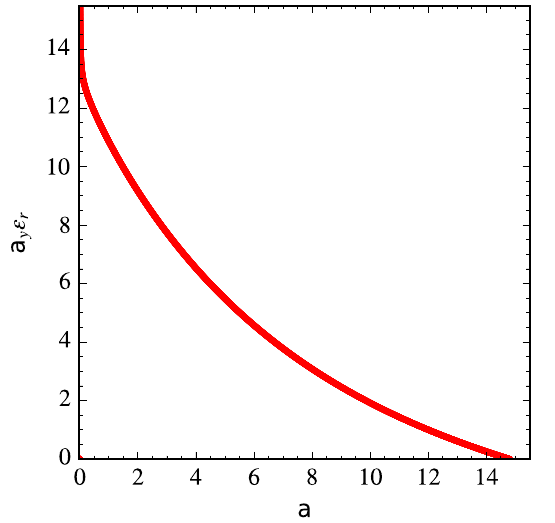
FIG. 3. Collection of all stationary points for the third-order normal resonance in a high-intensity coasting beam.